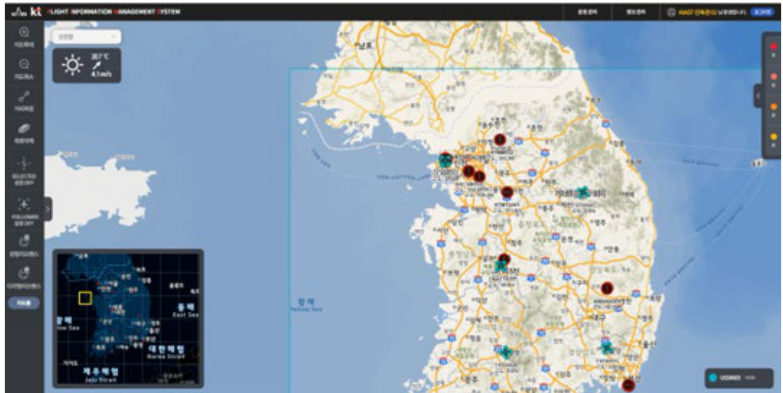
Figure 7. Drones identified through FIMS.